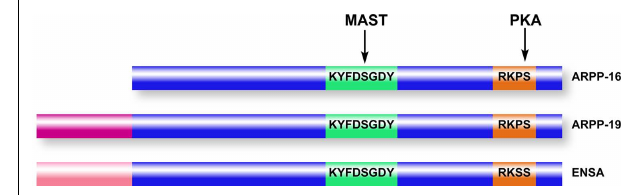
ARPP-19 containing an additional 16 amino acids at the N-terminus. ENSA is generated from a distinct gene, and contains a 20-amino acid N-terminal region distinct from ARPP-19.Within the conserved domains of the three proteins (blue), ARPP-16 and ARPP-19 are identical and ENSA is highly homologous. MAST kinases (or Gwl in non-mammalian systems) phosphorylate a common serine residue in a conserved central domain, while PKA phosphorylates a conserved site at the